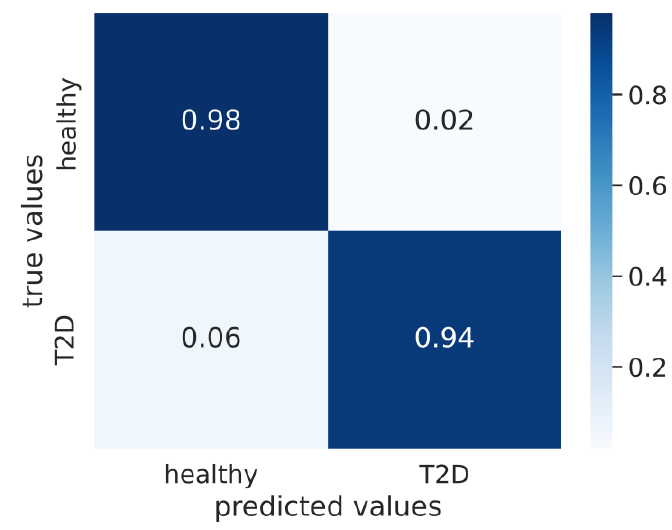
Figure 5. Confusion matrix of the test set from the original dataset.